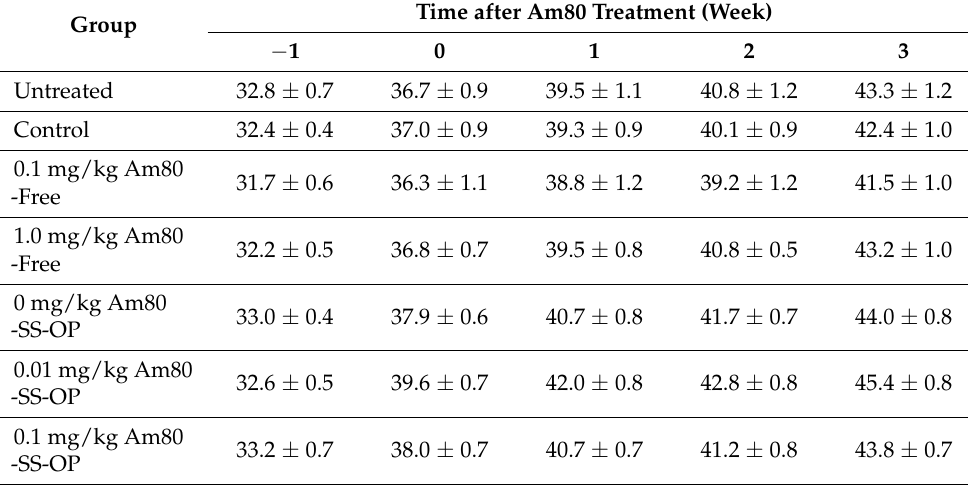
Table 2. Free Am80 and Am80-encapsulated SS-OP nanoparticles on the body weight decrease.